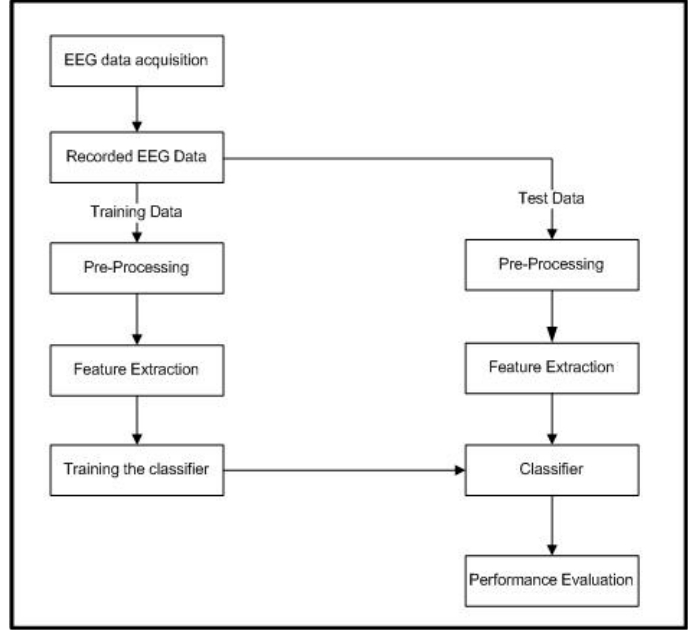
Figure 3. Methodology for data analysis.